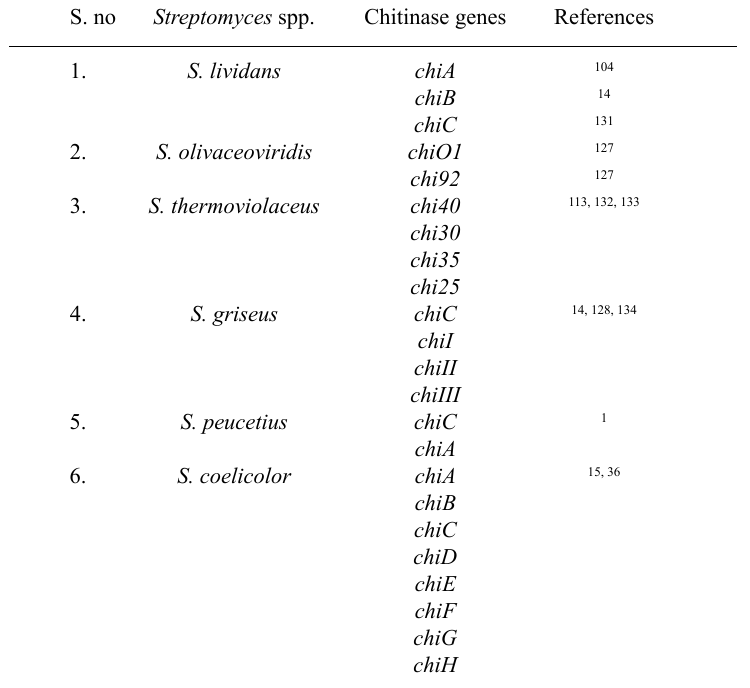
Table 2. Streptomyces expressing multiple chitinases